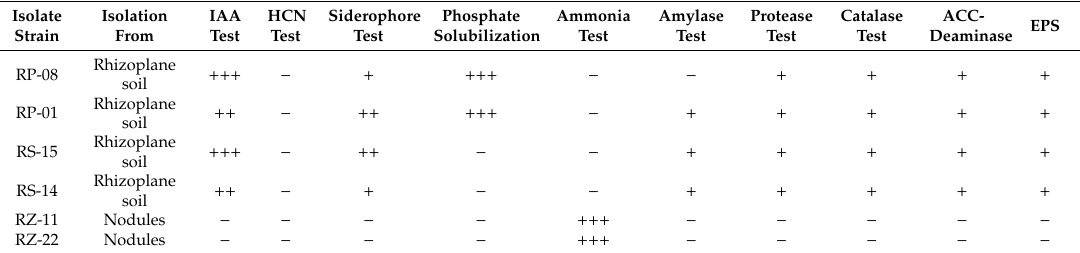
Table 2. Characterization (Biochemical parameters) of most e ffi cient isolated bacterial strains after screening.